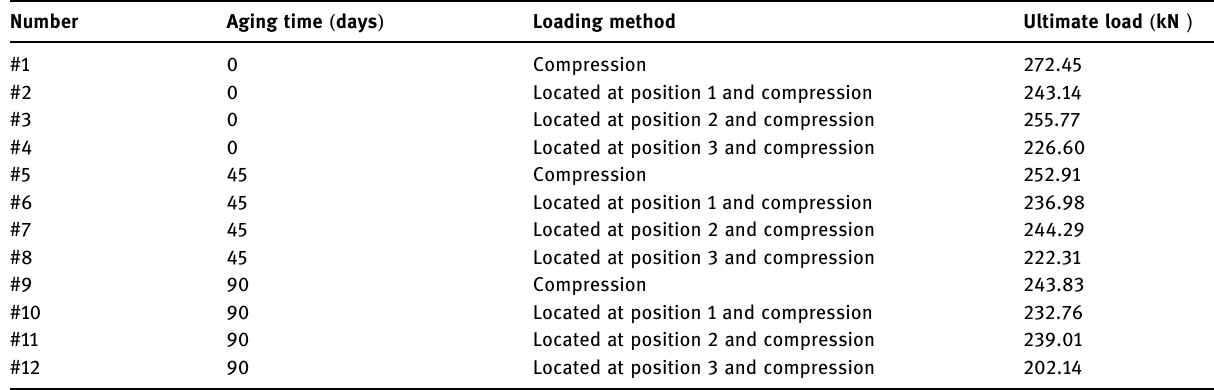
Table 3: Summary of experimental and simulation results